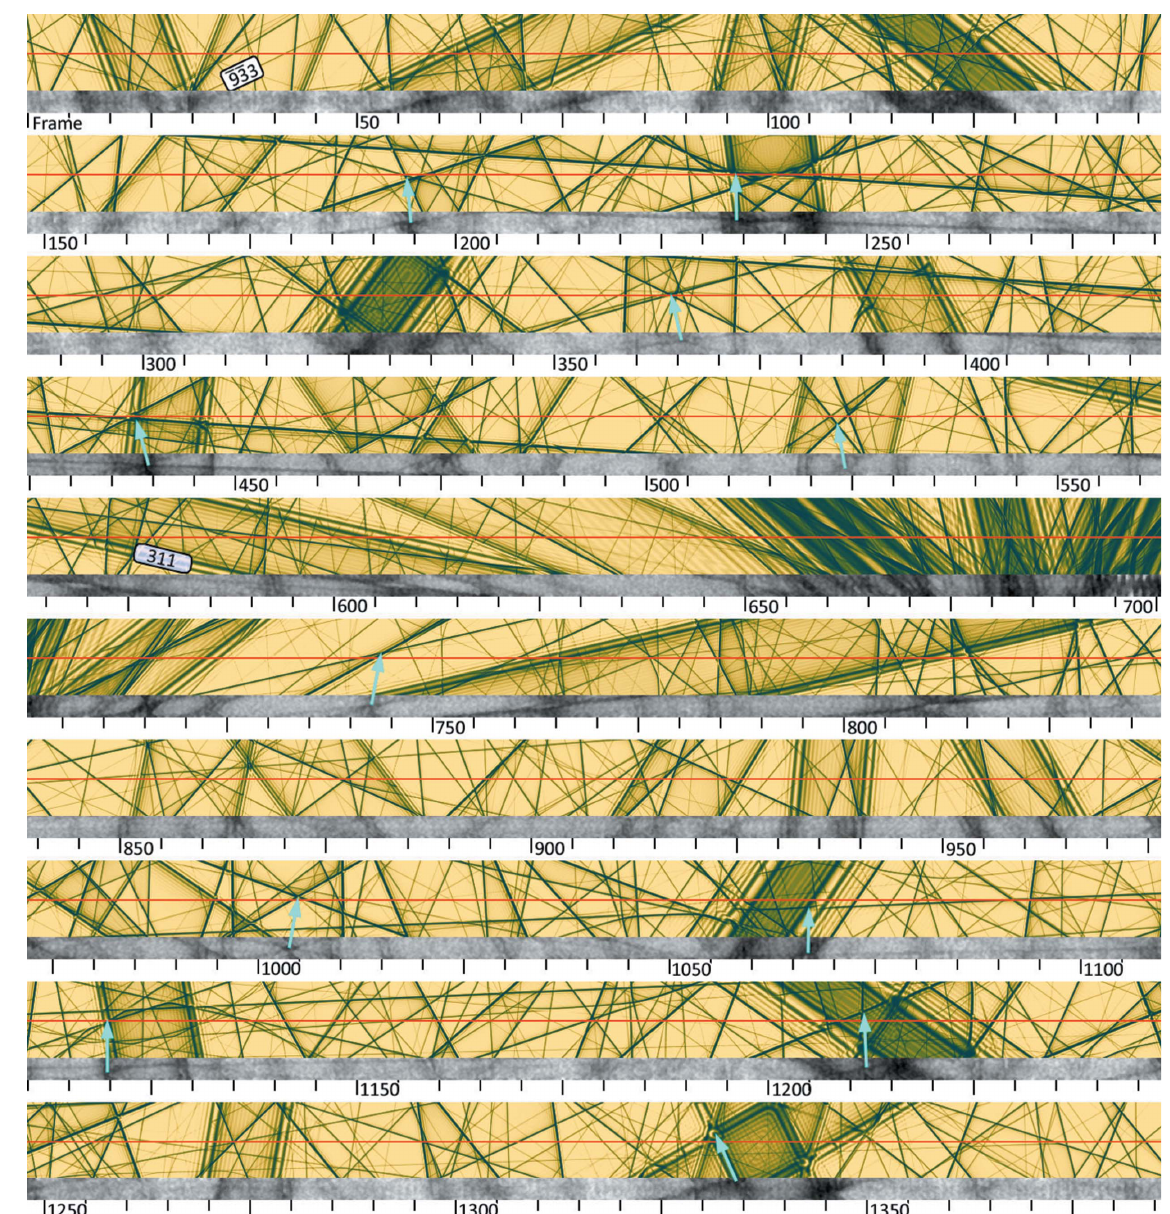
Figure 5 Dynamical simulation for the path of the 000 beam through reciprocal space (red line) in the silicon cRED data set, corresponding to 1387 frames (goniometer rotation of 143 (cid:3) about (cid:5) ). Frame numbers are indicated; note that one division = 5 frames = 0.5175 (cid:3) = 9 mrad. Each dark line corresponds to a Bragg condition for a diffracted beam, two of which (933, frames 30–50, and 311, frames 545–590) are labelled. Below the simulation, the experimental intensity of the 000 beam is shown. Some features that are clearly present in both simulation and experiment are indicated by arrows. The [110] zone axis lies a few degrees below the beam path around frame